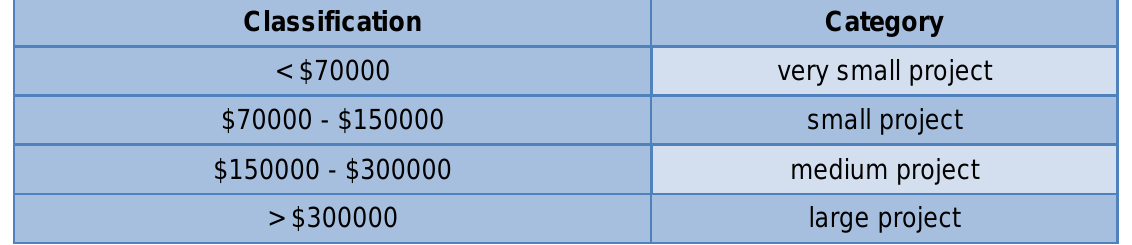
Table 2 Classification of road construction projects in West Bank (PECDAR, 2009) Attention was paid to the following points during data collection: